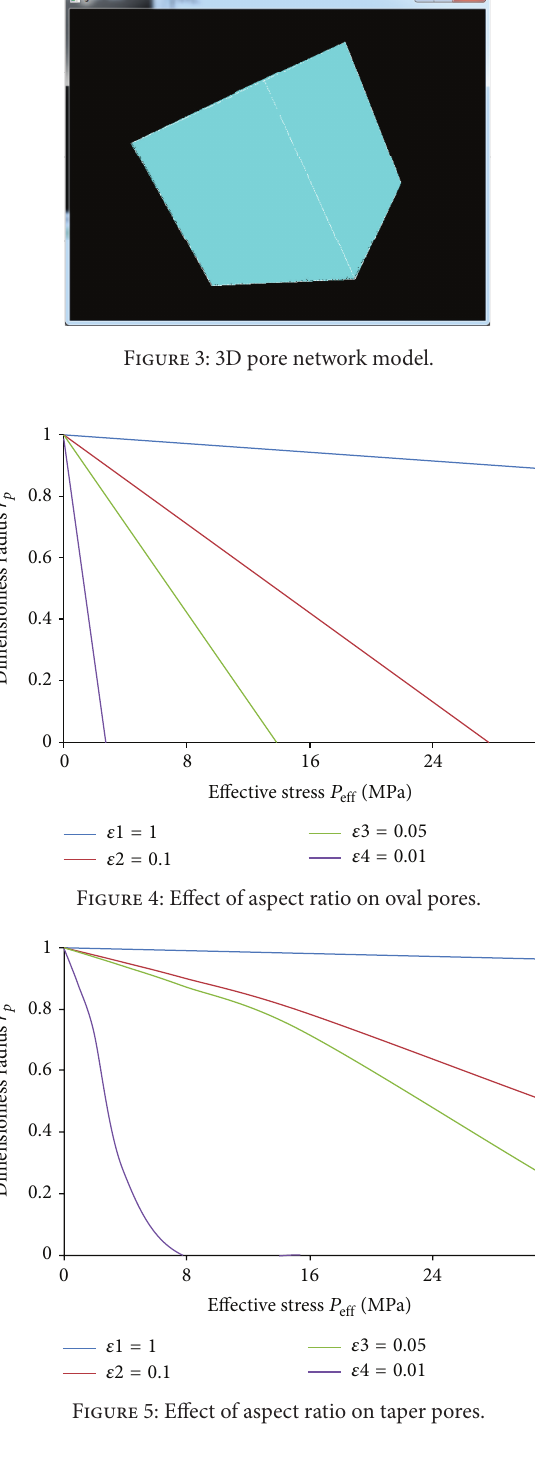
Table 2: (Log) uniform distribution.